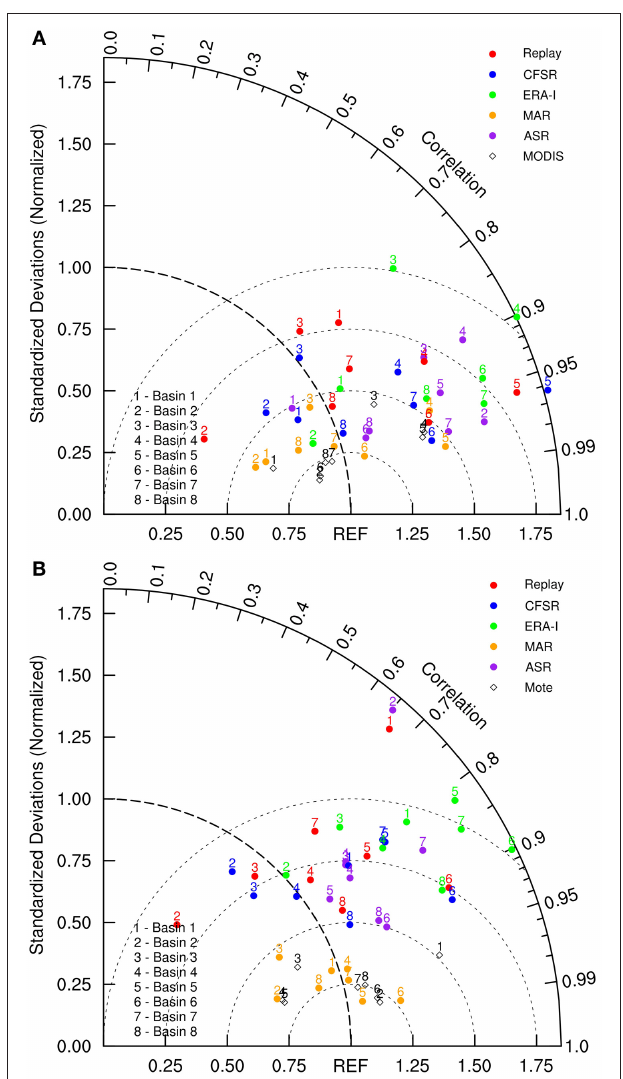
FIGURE 6 | Taylor diagrams of number of melt days for indicated drainage basins for (A) relative to passive microwave data and (B) relative to MODIS